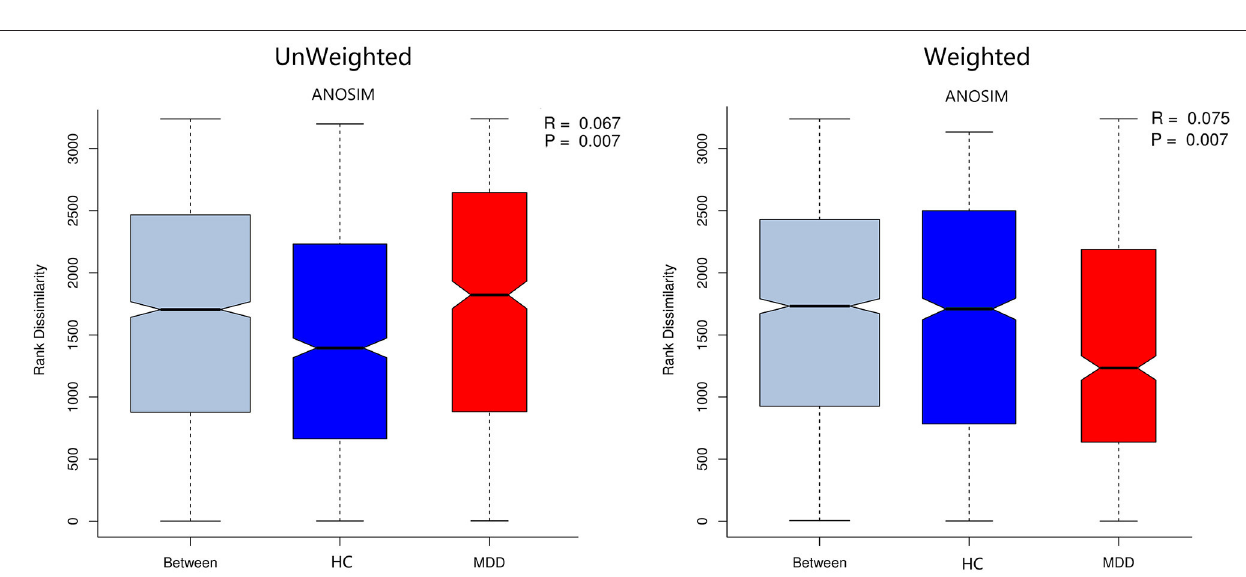
FIGURE 3 | Unweighted and weighted analyses of similarities (ANOSIMs) based on the distance matrix of UniFrac differences of the fecal microbial communities in the MDD group and HC. r > 0 means the difference between groups is greater than that within groups.